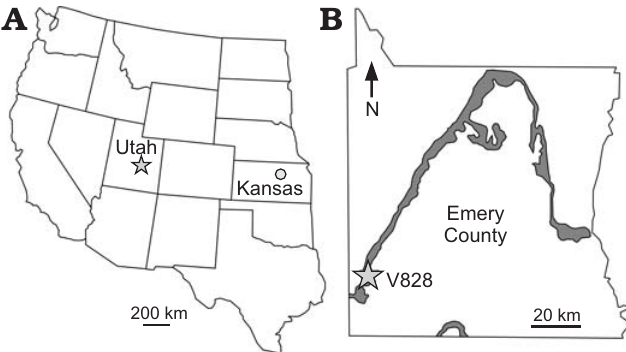
Fig. 1. Map of the western United States ( A ) with the approximate loca- tions of the holotype in Salina, Kansas (KWU uncatalogued; circle) and referred specimen in Emery County, Utah (OMNH 34500; star) and map of Emery County ( B ) with the approximate location of V868 (star) and the distribution of the Mussentuchit Member (grey area) (modified from Cifelli et al.